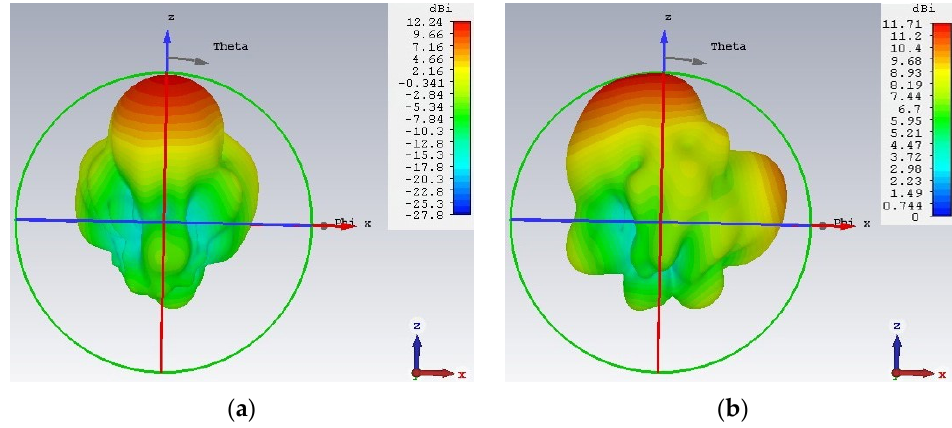
Figure 12. 3D Radiation Patterns at 28 GHz. ( a ) Ant1; ( b ) Ant2. Table 2. Simulated and measured gain of the MIMO antenna